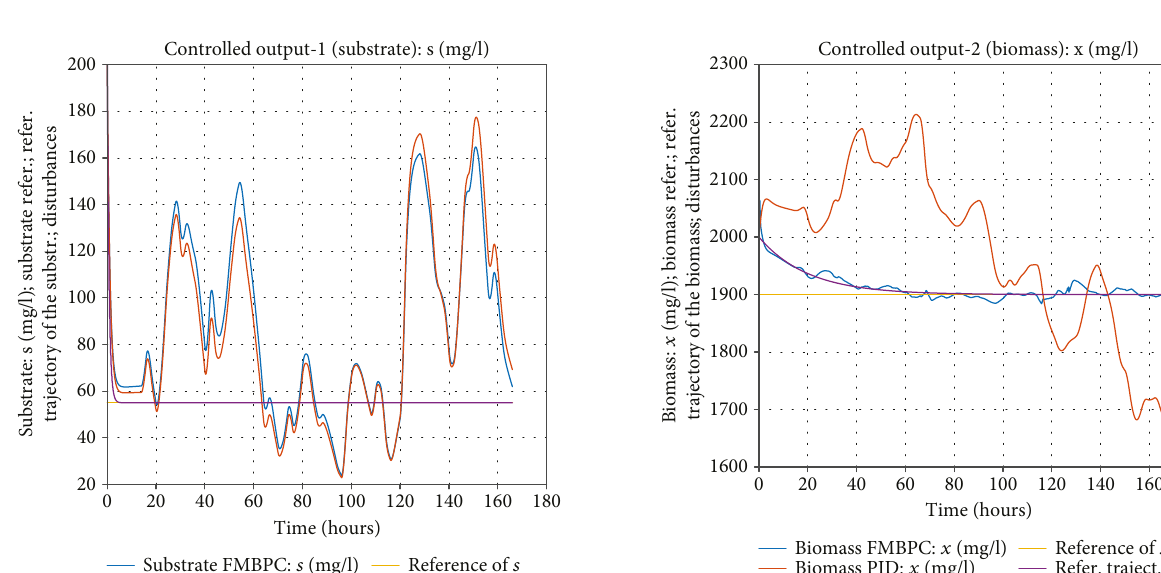
Figure 21: Reactor biomass by FMBPC and disturbances (case C). Figure 19: E ffl uent substrate by FMBPC and disturbances (case C).